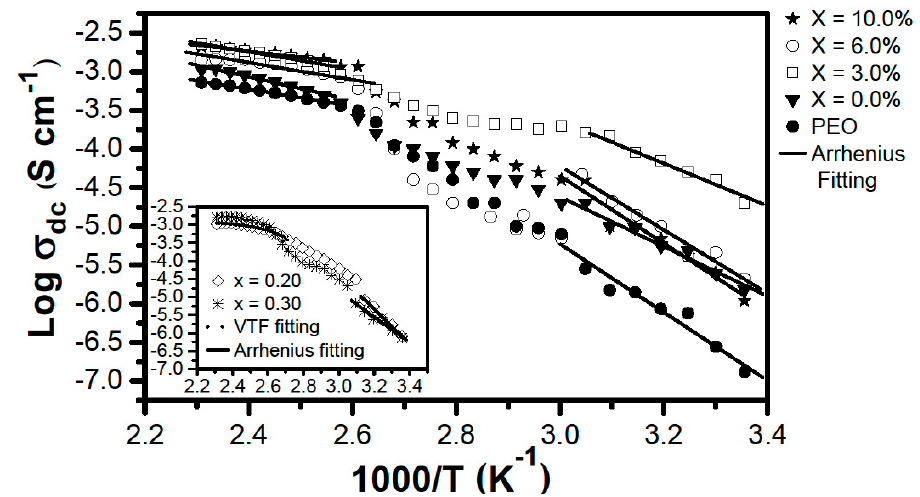
Figure 4. Conductivity as a function of the inverse of temperature for PEO, (PEO) 10 CF 3 COONa polymer electrolyte and (PEO) 10 CF 3 COONa + x wt.% Al 2 O 3 composite. The solid line represents the Arrhenius fitting and the dotted line represents the Vogel Tammann-Fulcher (VTF) fitting.